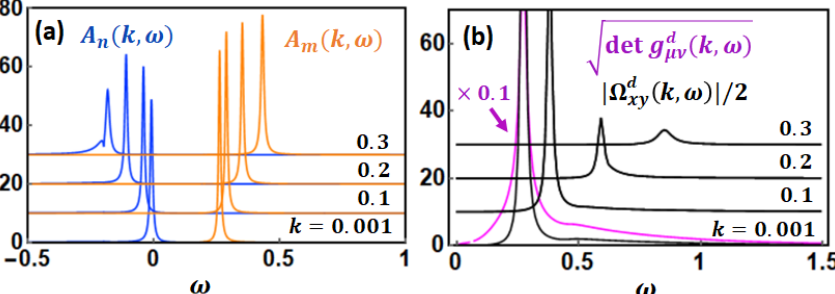
Figure 2: (a) Single-particle spectral function of the Chern insulator with impurity = 0.1 and impurity potential V = 1, plotted for several diagonal mo- density n i = k = k . Each line is shifted upward for the sake of presentation. menta k x y T = 0.03. (b) The chemical potential is set at µ = 0.13 and temperature at k B ( k , ω ) | / 2 and quantum metric spectral The Berry curvature spectral function | Ω d x y (cid:113) ( k , ω ) , which coincide at large momenta, signifying the metric- function det g d µν curvature correspondence, but deviate at small momenta due to the reduced band